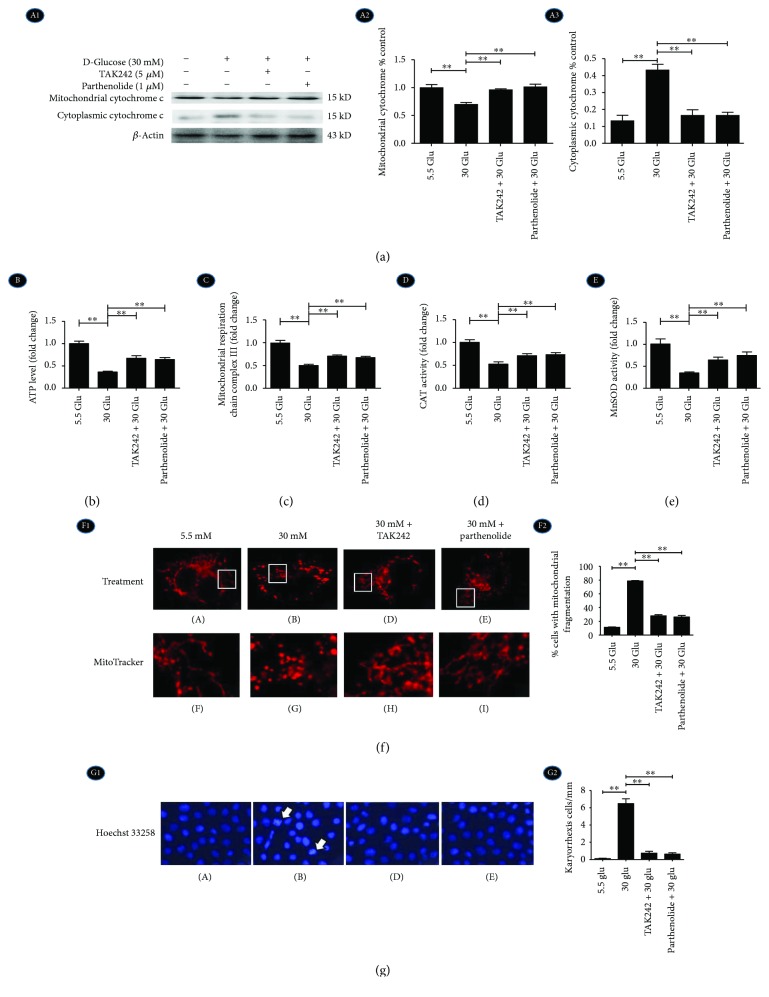
Inhibition of TLR4/NF-κB signaling reversed mitochondrial cytochrome C release, mitochondrial morphology, function, and early apoptosis in HK-2 cells under HG ambience. HK-2 cells were treated with TAK242 for 2 h prior to HG (30 mM) treatment for 24 h and with parthenolide and HG (30 mM) for 24 h. (a) A1–A3: Western blot shows protein expressions of mitochondrial cytochrome C and cytoplasmic cytochrome C. (b) The level of ATP production. (c) The activity of mitochondrial respiratory chain complex III. (d) Activity of CAT. (e) Activity of MnSOD. ∗∗P < 0.01. The values in b–e were displayed as fold change compared to the control. (f) Fluorescence microscopy shows mitochondria stained with MitoTracker Red CMXRos (red) (F1) and was evaluated to determine the percentage of cells that fragmented mitochondria (F2). (g) Hoechst 33258 staining shows early apoptosis of tubular cell nuclei (blue).